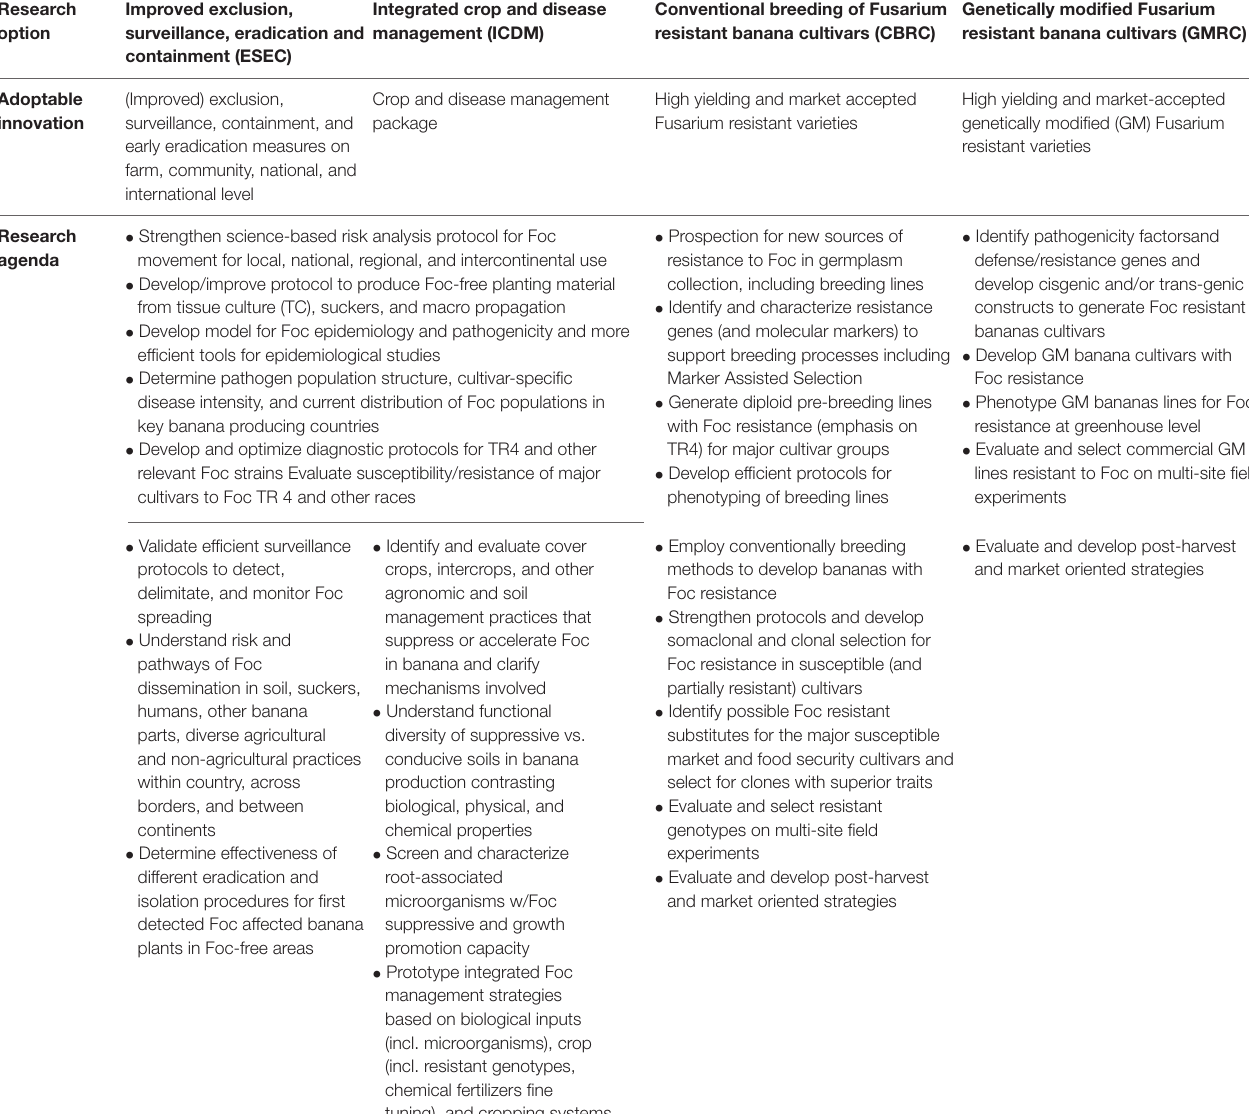
TABLE 1 | Description of the four assessed research options to address Fusarium wilt of